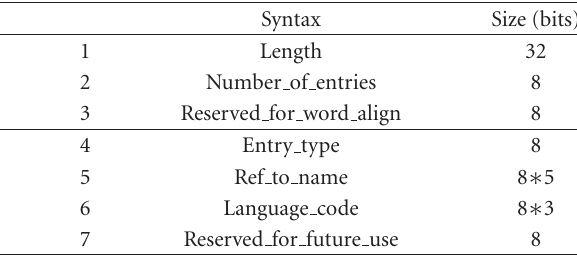
Table 6: Application cache information.